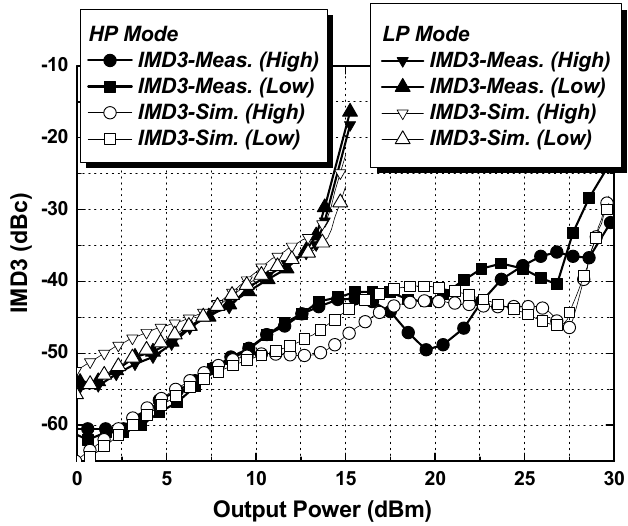
Figure 14. Measured IMD3 results.